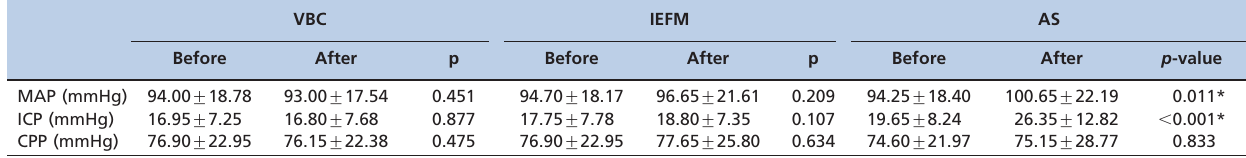
Table 1 - The results of the cerebral hemodynamic variables, reported as means and standard deviations. VBC IEFM AS Before After p Before After p Before After p -value